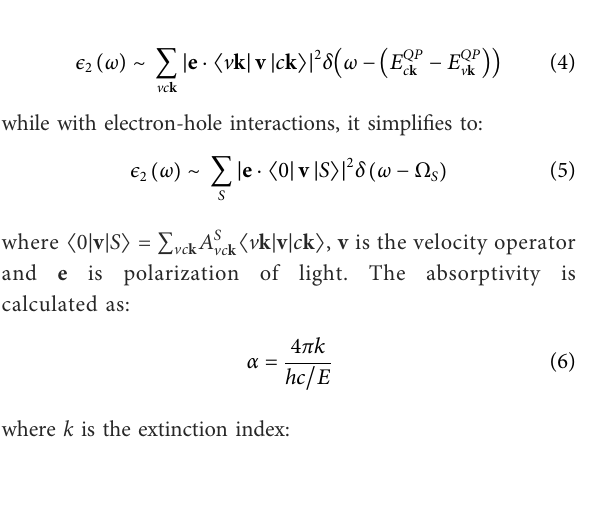
FIGURE 4 Imaginary and real parts of the dielectric function of armchair graphene nanoribbons calculated within the GW-BSE and GW-RPA approximations. Imaginary and real parts of the dielectric function for (A,B) 3 n + 1 family, (C,D) 3 n family and (E,F) 3 n + 2 family. Solid lines represent absorption spectra from GW + BSE calculations; dashed lines represent absorption spectra from GW + RPA